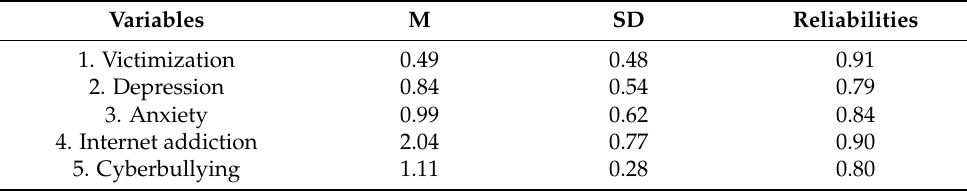
Table 1. Means, Standard Deviations, and Reliabilities of all Study